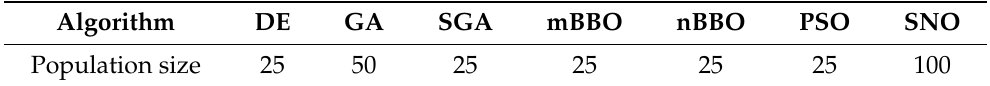
Table 2. Numerical results of the